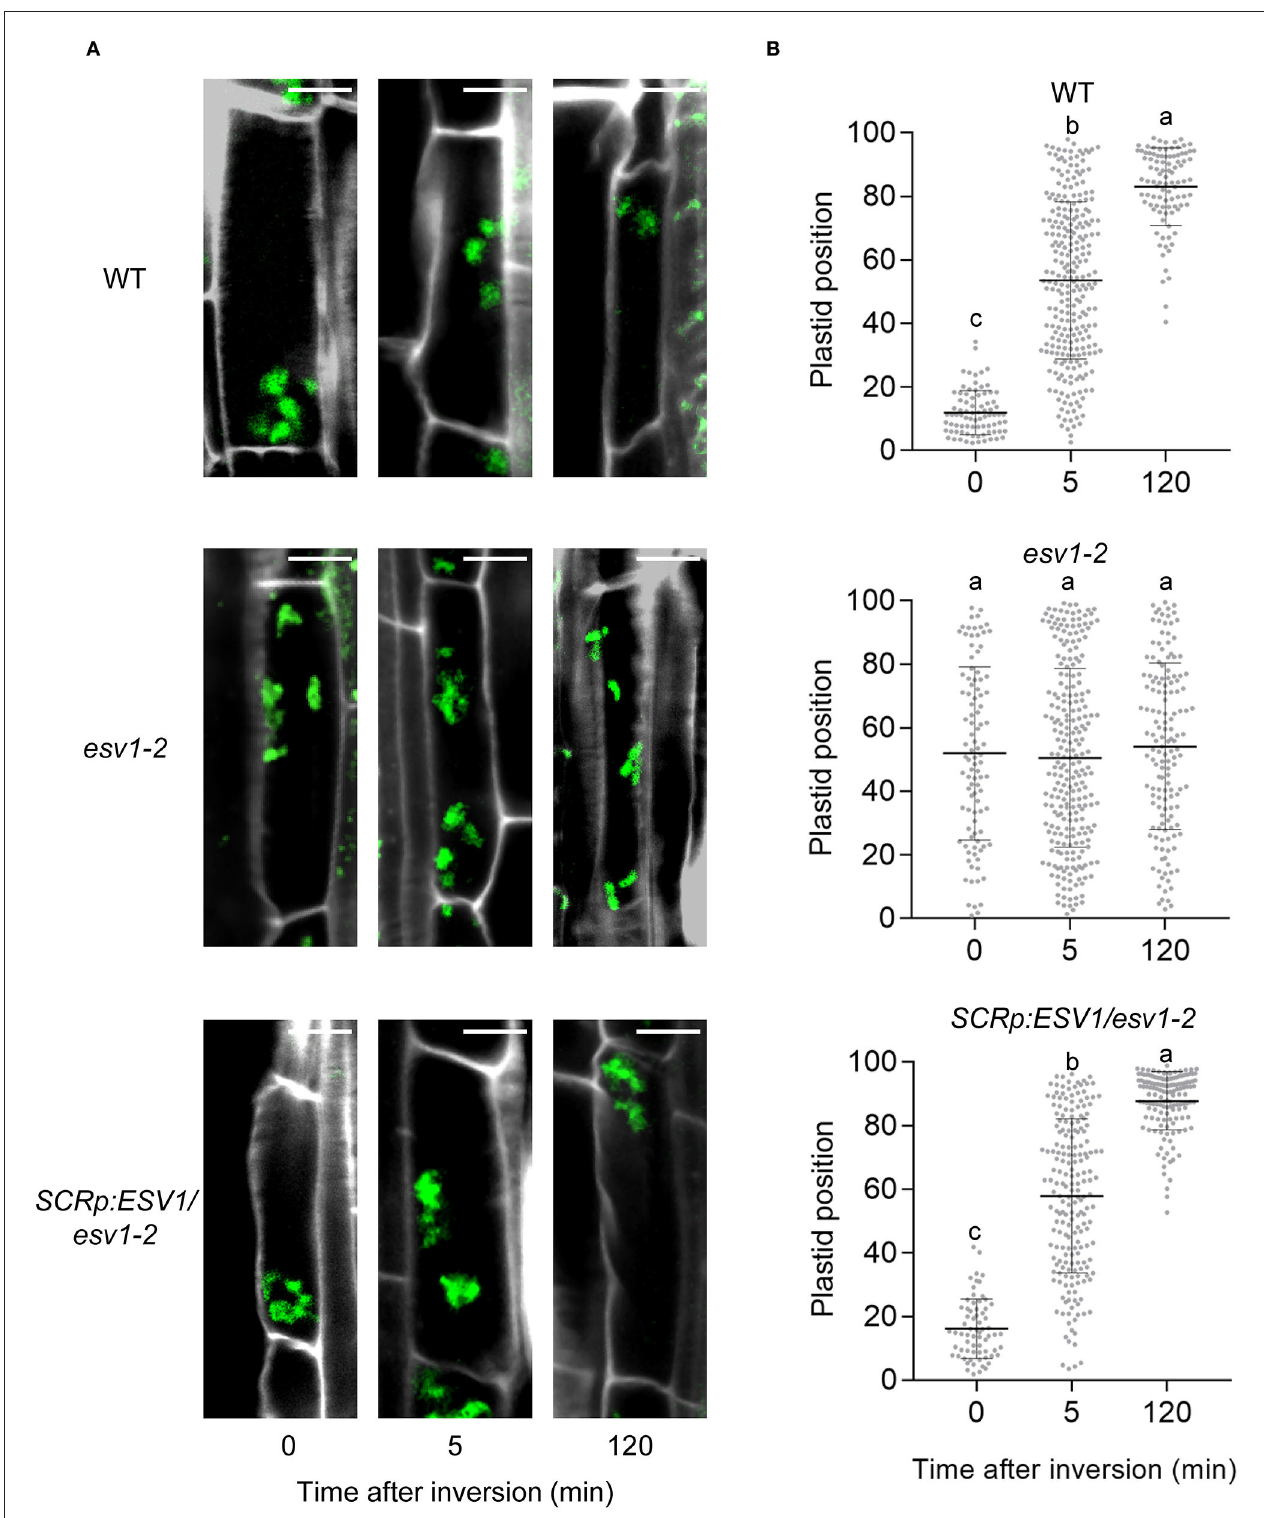
FIGURE 8 | Endodermal plastids of the ESV1 mutant do not sediment toward the direction of gravity. (A) Confocal images showing no sedimentation of endodermal plastids in the ESV1 mutant. Three day-old dark grown seedlings expressing mCitrine fused with rubisco small subunit transit peptide were inverted in the dark. At the indicated times after inversion, the seedlings were fixed with paraformaldehyde and confocal images were taken after staining their cell walls with Calcofluor white. Cell